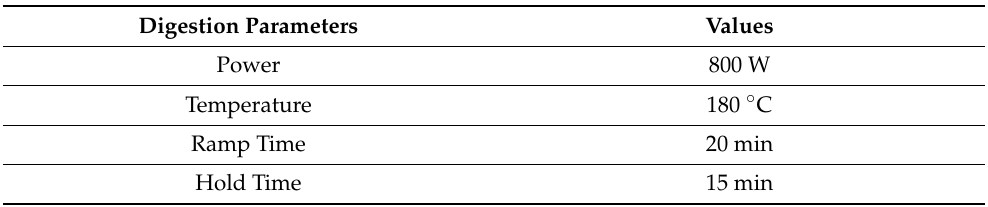
Table 1. Parameters for microwave-assisted acid